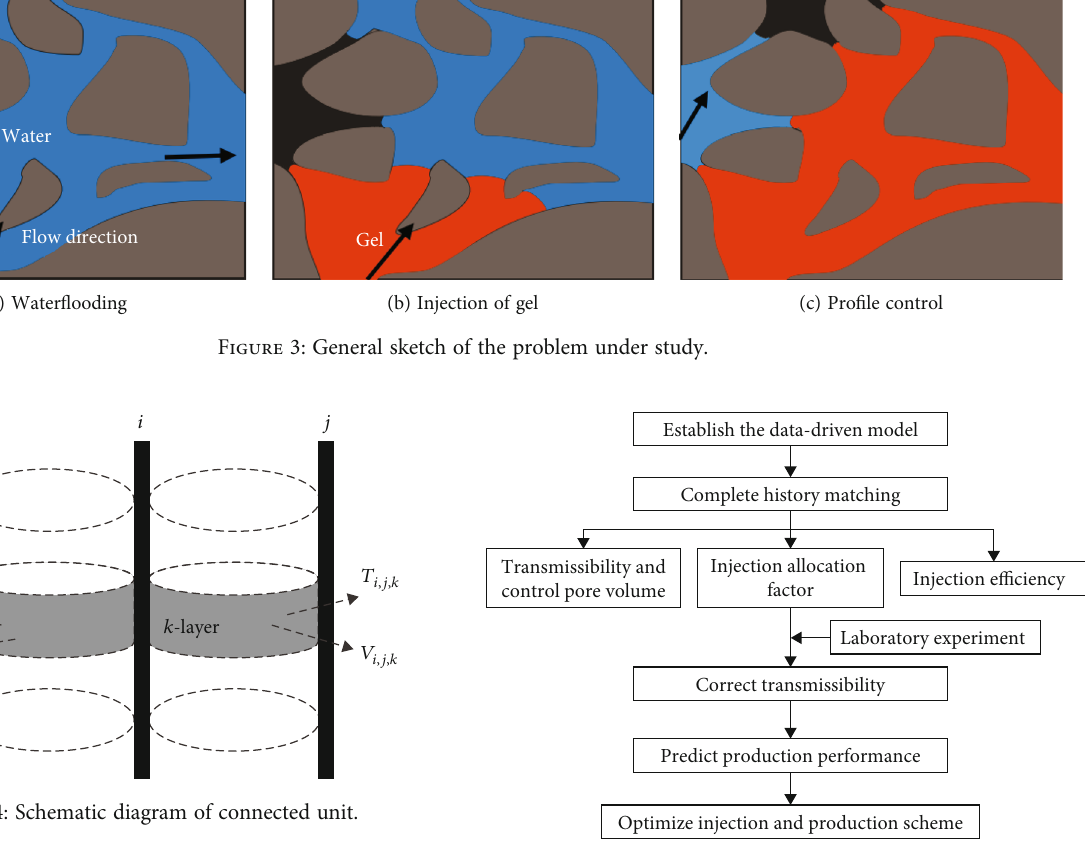
Figure 5: The work fl ow of the proposed